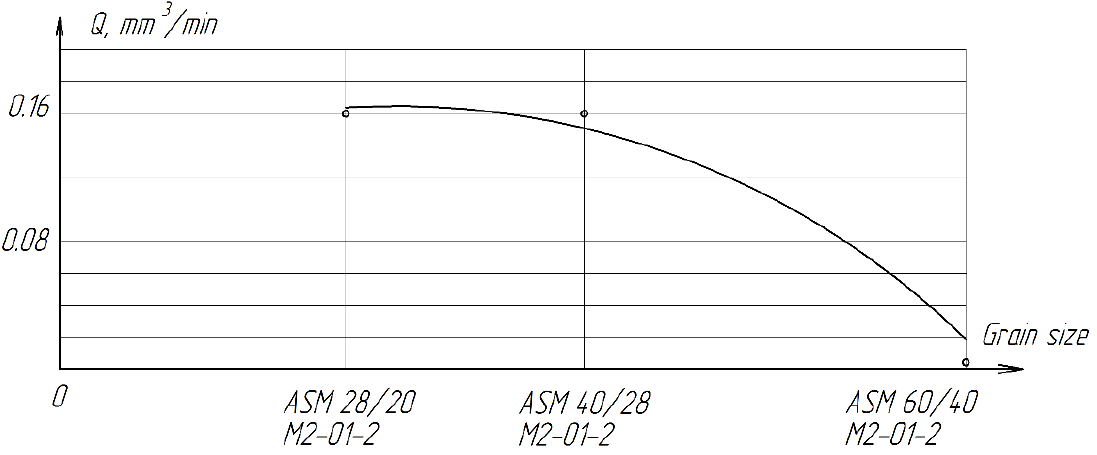
Figure 19. The effect of grain size on the processing performance of ZrO 2 ceramics. Table 8. Results of lapping ZrO 2 ceramics with free and fixed